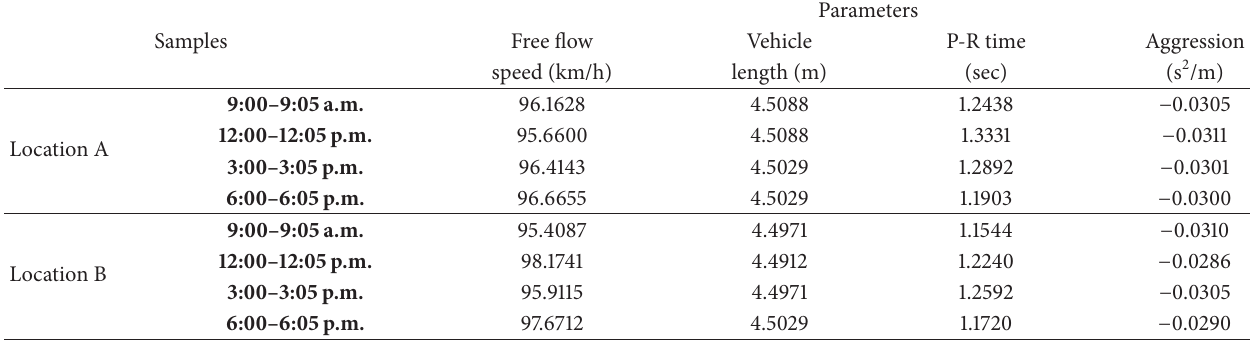
Table 2: Calibration results for sample data sets by bisection based